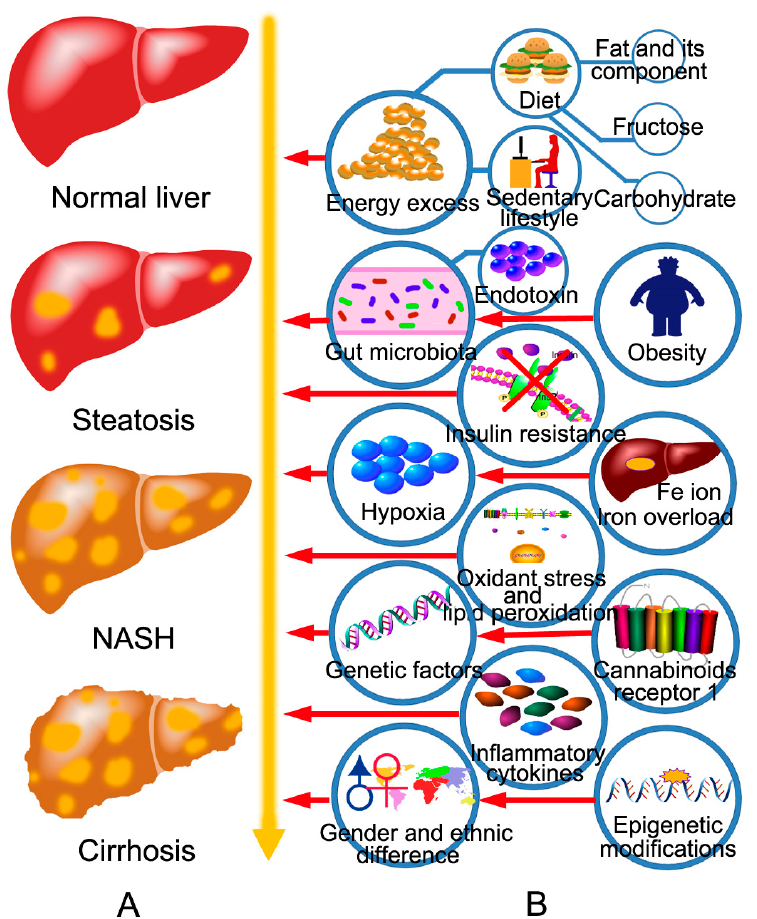
Figure 1. The disease spectrum of NAFLD and the factors that influence the progression of NAFLD. ( A ) The spectrum of NAFLD ranges from simple steatosis to NASH and cirrhosis. Simple steatosis is characterized by the ectopic accumulation of lipid droplets in the cytoplasm of hepatocytes without hepatocyte injury, inflammation, and fibrosis histologically. Steatosis is self-limited and can be reversed by lifestyle modifications. Steatosis can develop to NASH, which differs from simple steatosis in the presence of hepatocyte injury, inflammation, and fibrosis. Long-term NASH leads to cirrhosis. In NASH-related cirrhosis, normal liver structure is damaged and replaced by type 1 collagen, and pseudolobules are formed; ( B ) The factors that influence the progression of NAFLD include energy excess, obesity, insulin resistance, genetic factors, gender and ethnic difference, gut microbiota, hypoxia, oxidative stress and lipid peroxidation, inflammatory cytokines, liver iron overload, endogenous cannabinoids receptor 1, and epigenetic modifications. Energy excess includes diet and sedentary lifestyle.